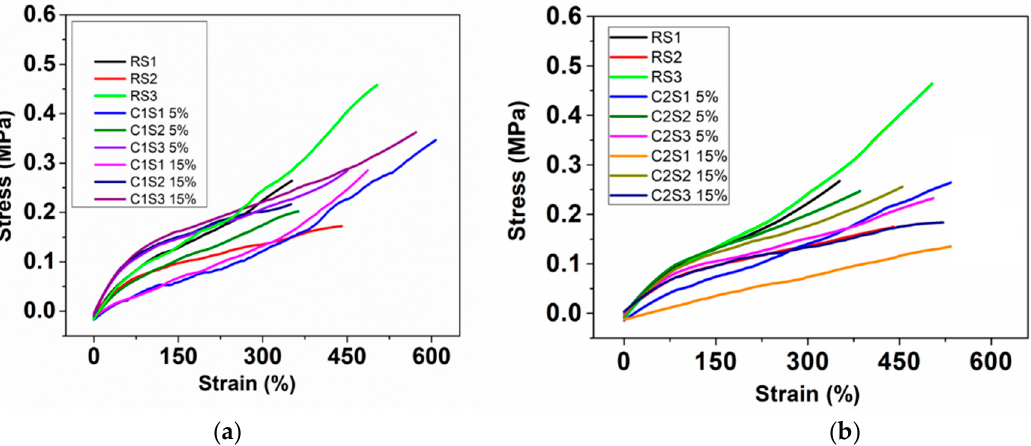
Figure 5. Stress–strain results for the tested samples: ( a ) variation of properties with siloxane molecular weight for samples with iron (C1); ( b ) variation of properties with siloxane molecular weight for samples with chromium (C2).